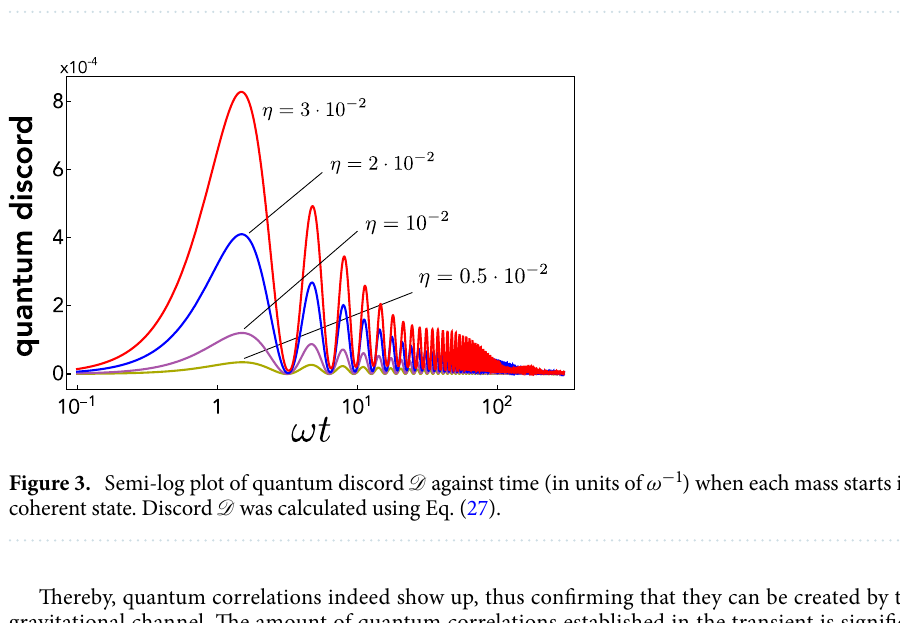
Figure 2. Semi-log plot of mutual information I against time (in units of ω − coherent state. Note that the growing frequency of damped oscillation is due to the logarithmic scale.